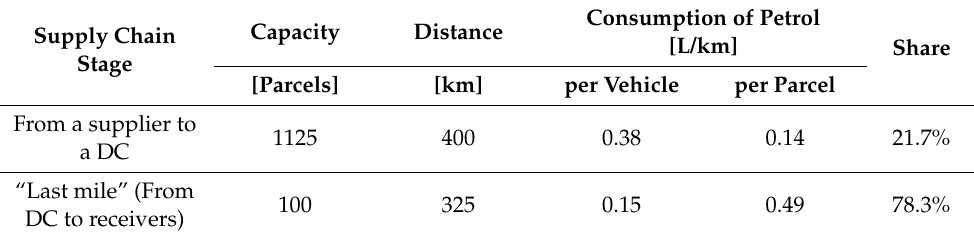
Table 2. Simulations of consumption of petrol in an e-commerce supply chain. Supply